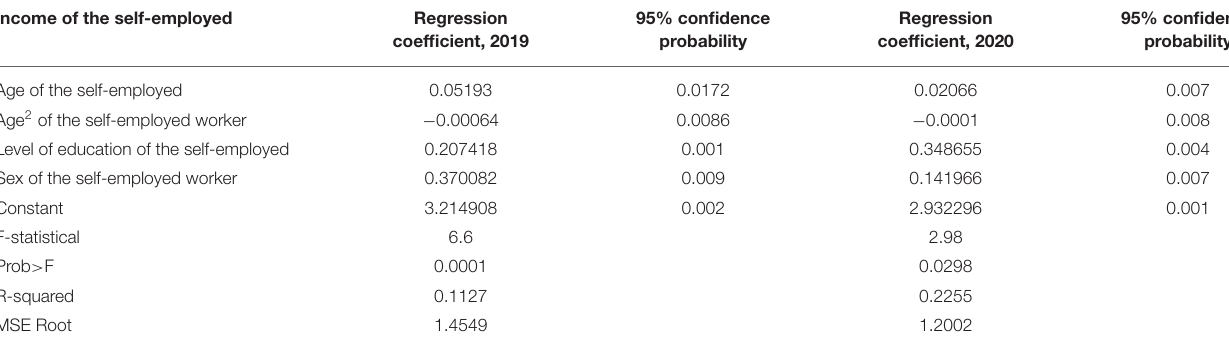
TABLE 2 | Linear regression model for determinants of the economic income of the independent worker. Income of the